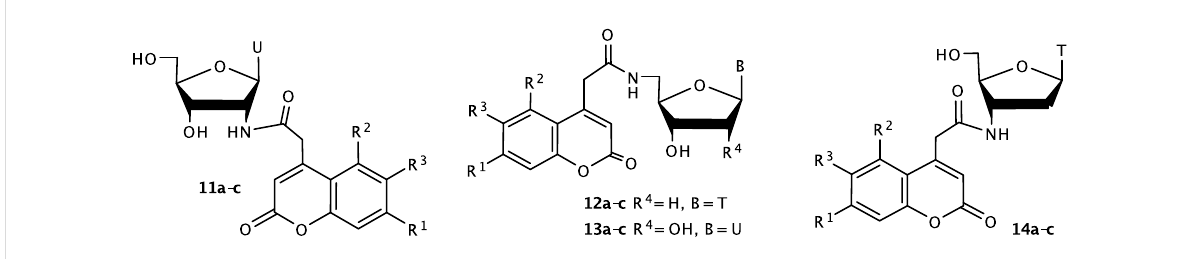
Figure 2: Coumarin labeled nucleosides prepared by intermolecular Staudinger ligation.